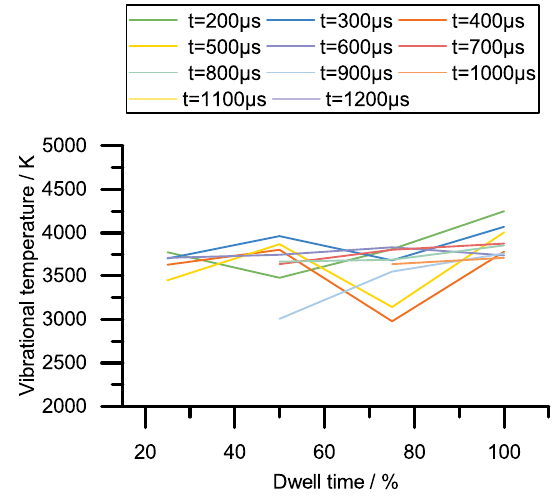
Fig. 11 Vibrational temperatures of different time intervals in the positive column depending on the dwell time of the ignition coil